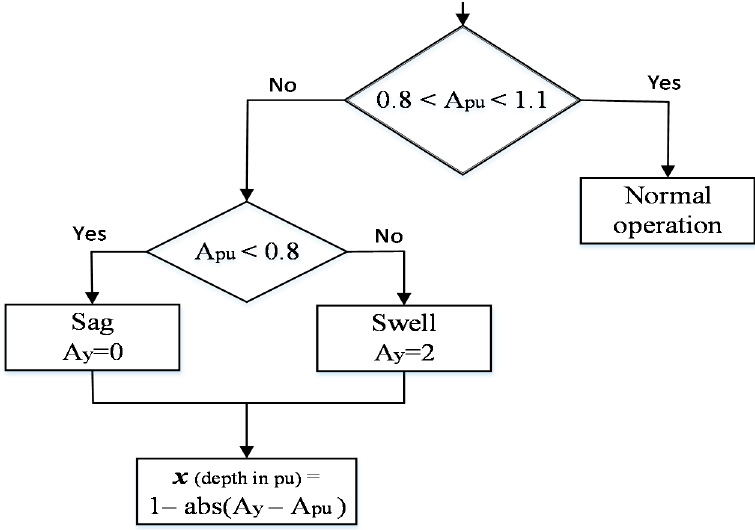
ff erentiating voltage sags from voltage Figure 17. Algorithm used for differentiating voltage sags from voltage swells. Figure 17. Algorithm used for di